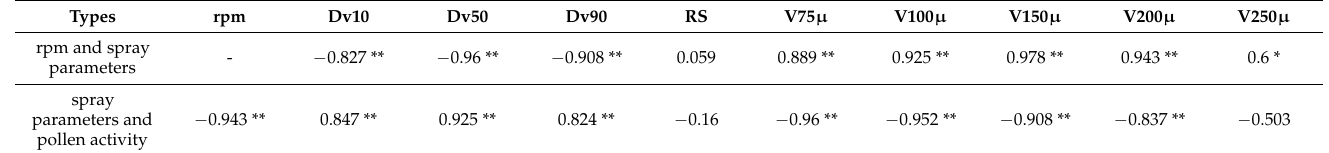
Table 4. Correlation analysis between RA revolution speed and spray parameters and pollen activity.